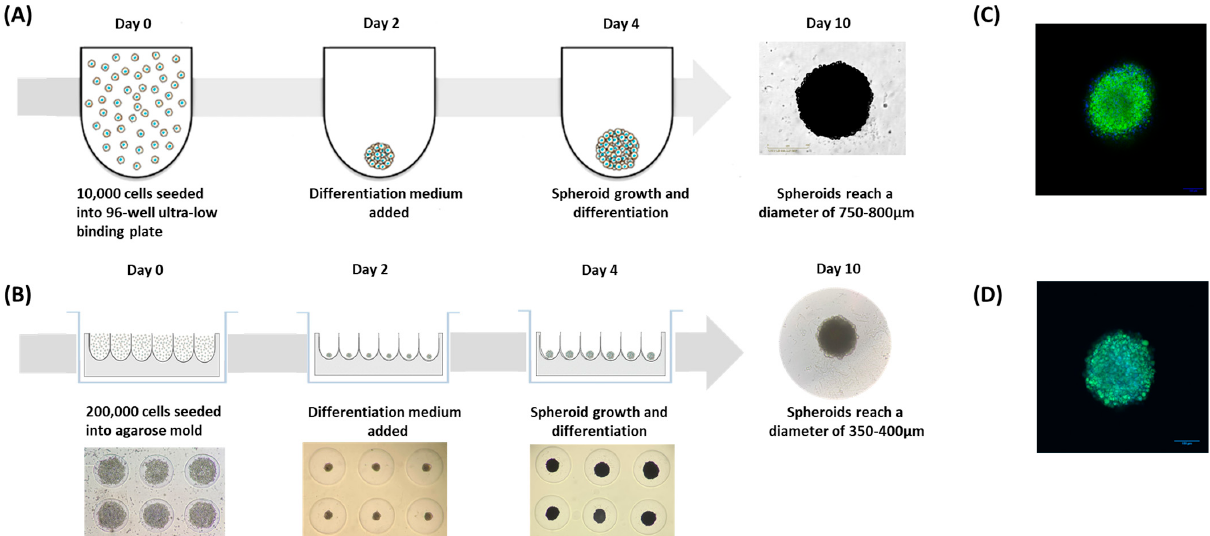
Figure 5. Generation of the 3D adipospheroids. ( A ) Using 96-well ultra-low-binding, U-shaped- bottom plates at 10,000 cells/well; ( B ) using an agarose mold with 81 wells at 200,000 cells/mold. With both methods, differentiation started at day 2 and ended at day 10; ( C ) confocal microscopy of adipospheroids formed in the plates with Bodipy and DAPI labeling in Vectashield mounting medium; ( D ) confocal microscopy of adipospheroids formed in the agarose mold with Bodipy and DAPI labeling in Vectashield mounting medium (Micro Zeiss Cell Observer Spinning Disk, ×20 Plan Apochromat 20×/0.8 M27).